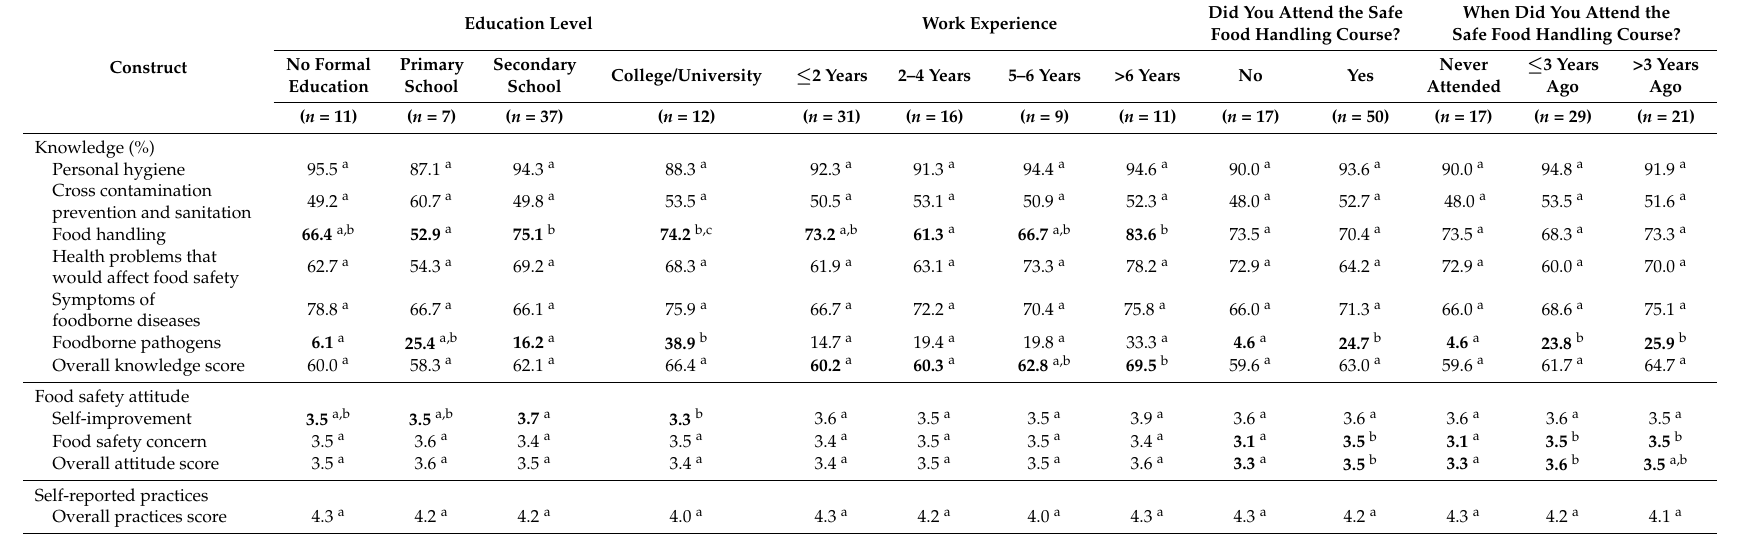
Table 4. Attribution of food safety knowledge, attitude, and self-reported scores to educational level, work experience, and safe food handling course of participants ( n =